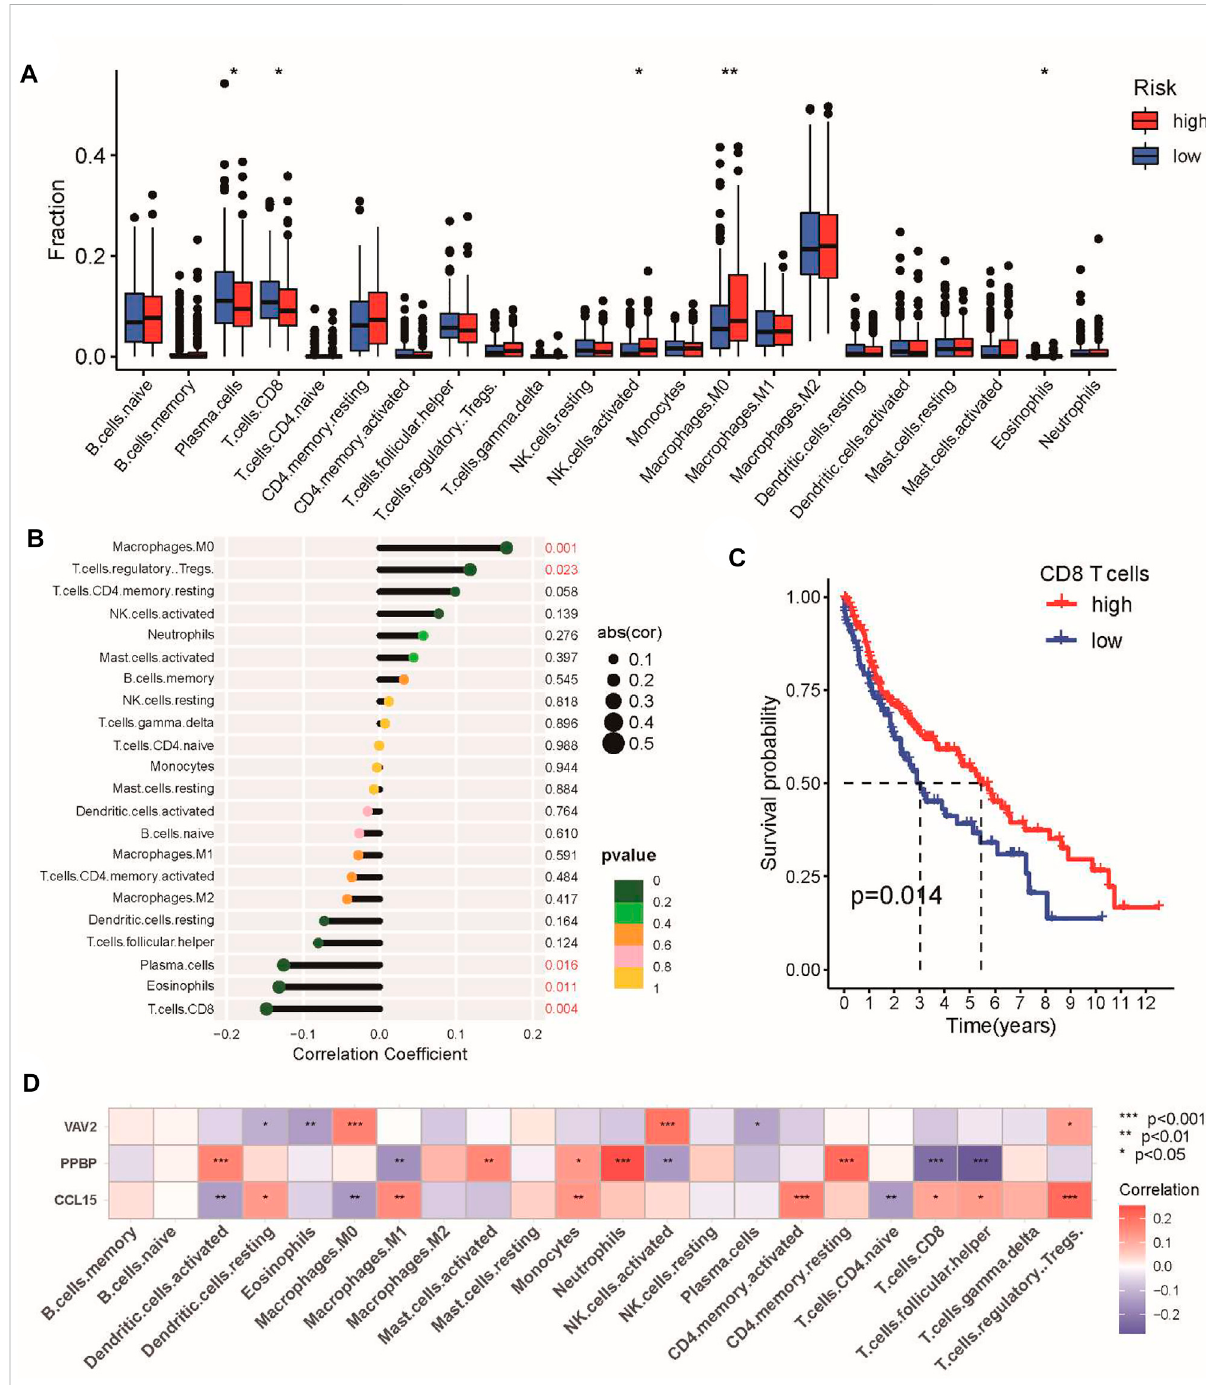
FIGURE 7 Characteristics of immune in fi ltrating cells in the high-risk and low-risk groups. (A) Differences in the abundance of immune-in fi ltrating cells betweenthehigh-riskandlow-riskgroups. (B) Correlationanalysisbetweenimmune-in fi ltratingcellsandtheriskscore. (C) Kaplan – Meieranalysisof prognosis according to the proportions of CD8 T-cells. (D) Correlation analysis of immune cells and three genes in the CSRG signature. * p < 0.05, ** p < 0.01, and *** p <